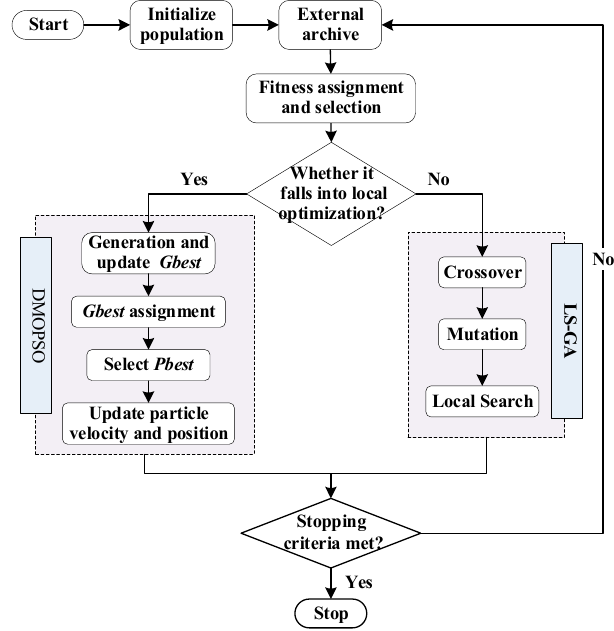
Figure 9. The flow chart of the hybrid strategy for HGA-PSO1. (3) Hybrid Strategy of HGA-PSO2 The other method of hybrid strategy based on LS-GA and PSO is: The population is divided into two subpopulations for LS-GA and PSO, and nondominated sorting and crowding distance-based fitness assignment strategies of the NSGA-II algorithm are used to implement the competitive selection. LS-GA selects the initial population from the external archive by selection operation to optimize the solution in the external archive, and PSO selects individual particles from the overall parent population for global search. The flow chart of the hybrid strategy of HGA-PSO2 is shown in Figure 10.